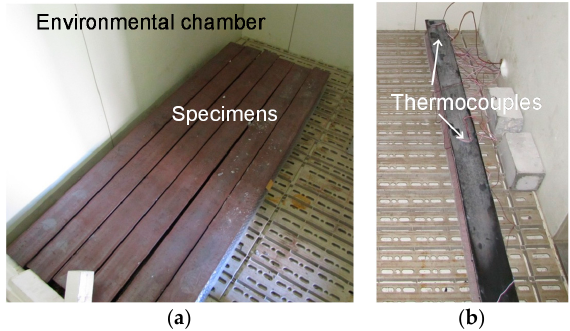
Figure 3. Thermal cycling in an environmental chamber: ( a ) test in progress; ( b ) thermocouples to monitor temperature variation.